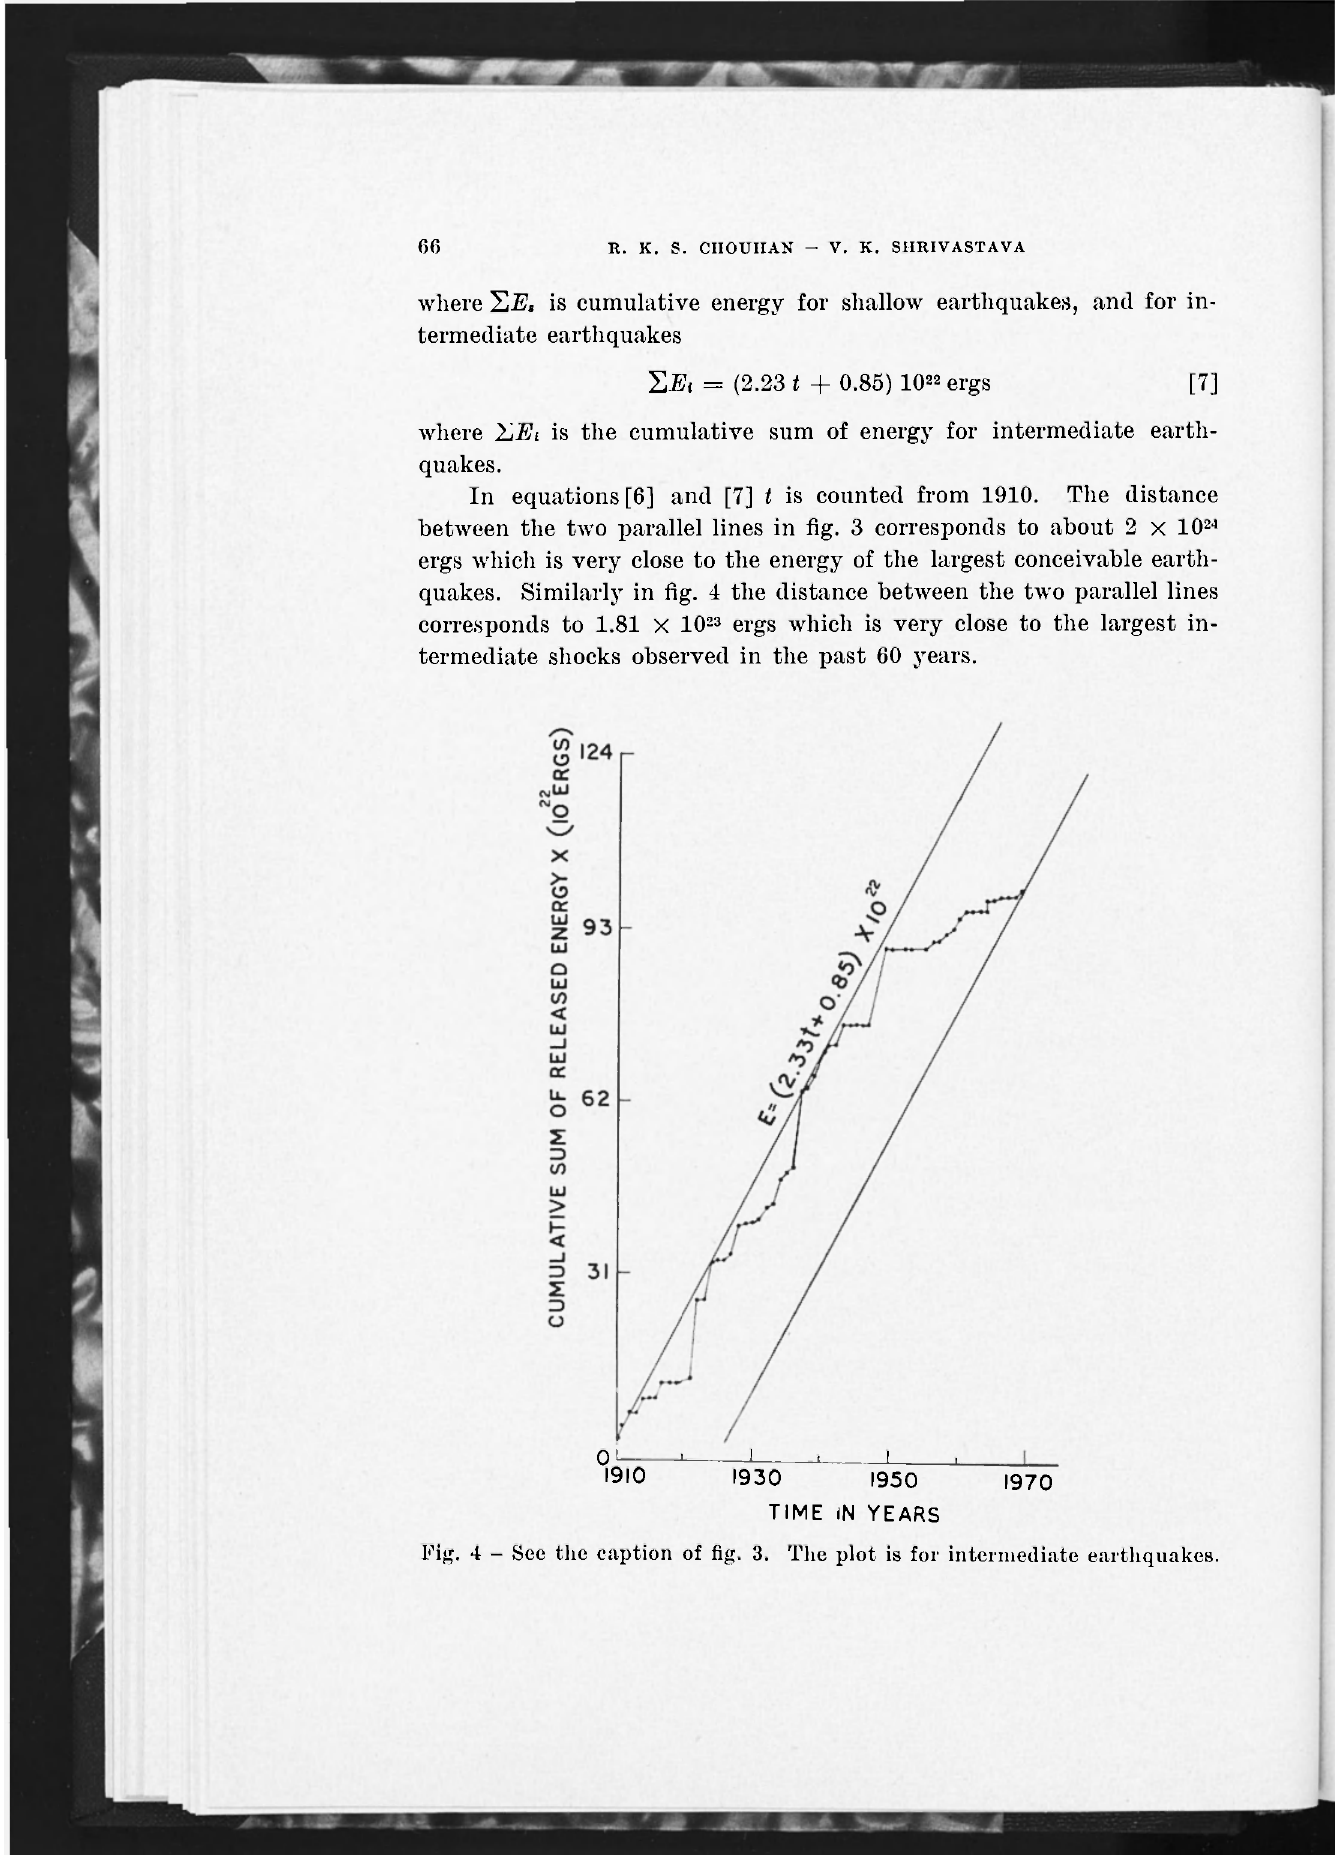
Fig. 4 - See the caption of fig. 3. The plot is for intermediate